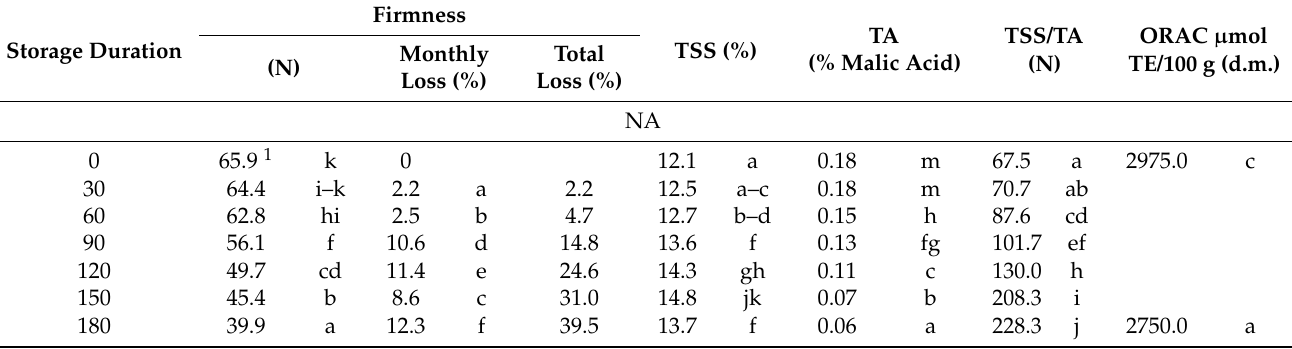
Table 7. Effect of storage technology on the quality parameters of pears in